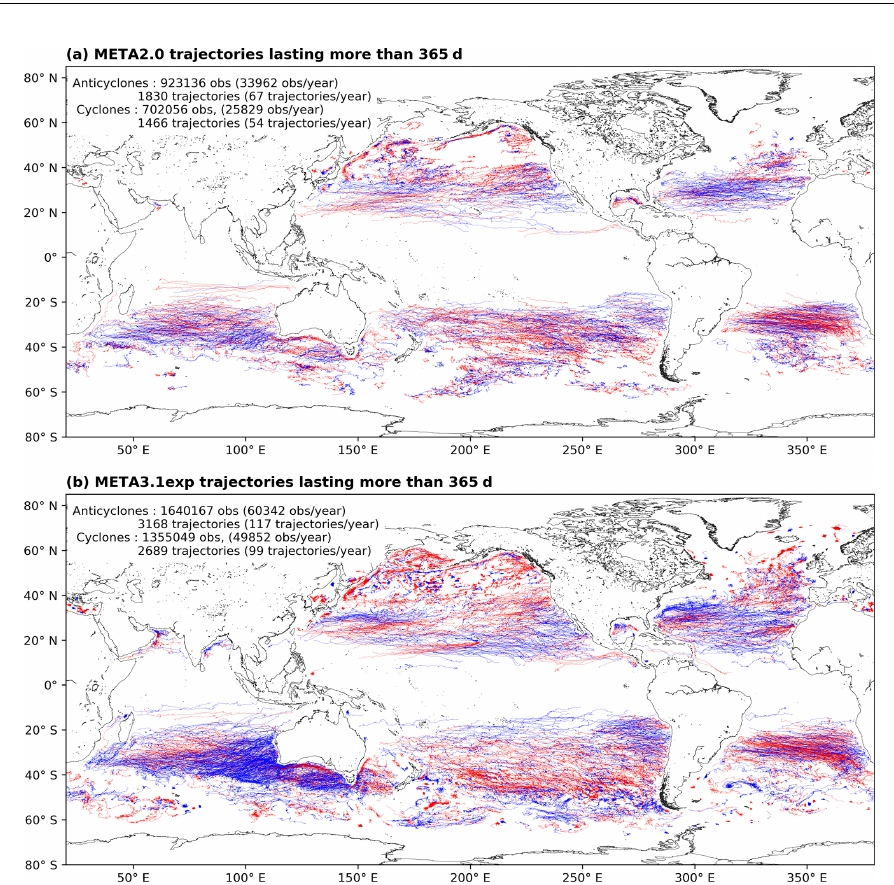
Figure 11. Trajectories lasting more than 365d from (a) META2.0 and (b) META3.1exp. Cyclones are in blue, anticyclones in red.